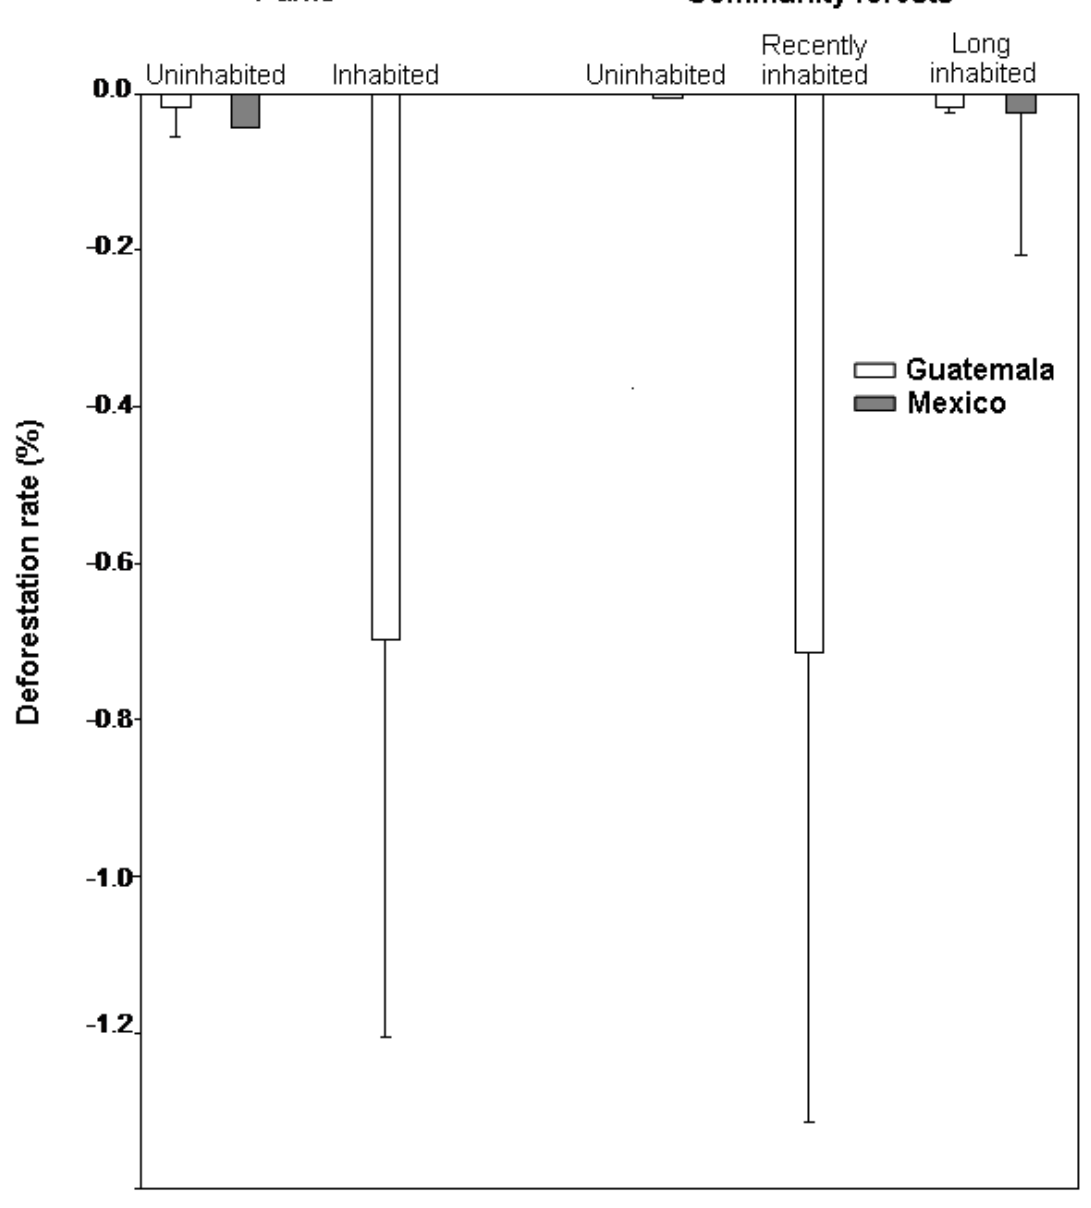
Fig. 3. Mean annual deforestation rates and standard deviation in protected areas and community forests in the Maya Forest of Mexico and Guatemala by human presence: uninhabited, inhabited, recently inhabited, and long